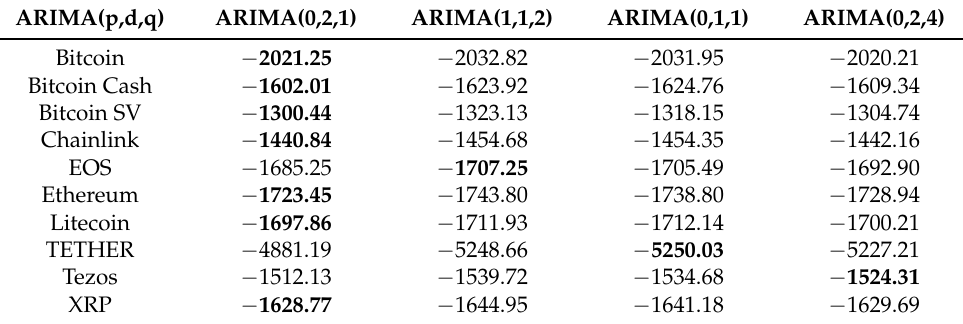
Table 3. Choosing the best ARIMA model based on AIC values (robust model).